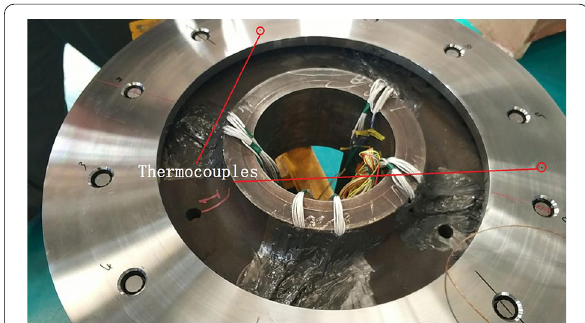
Figure 4 Distribution diagram of the thermocouple of the brake disc friction ring